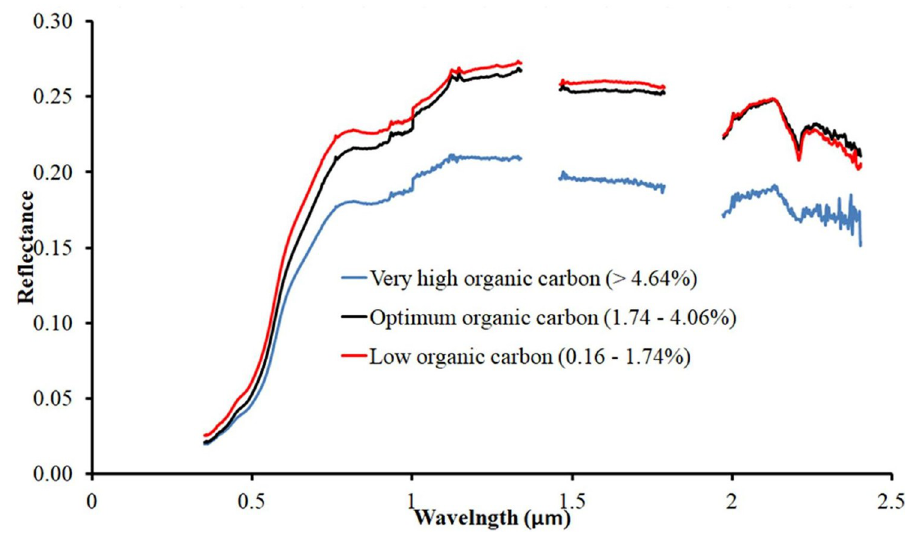
Fig 8. Effects of soil organic carbon content on soil spectral reflectance.